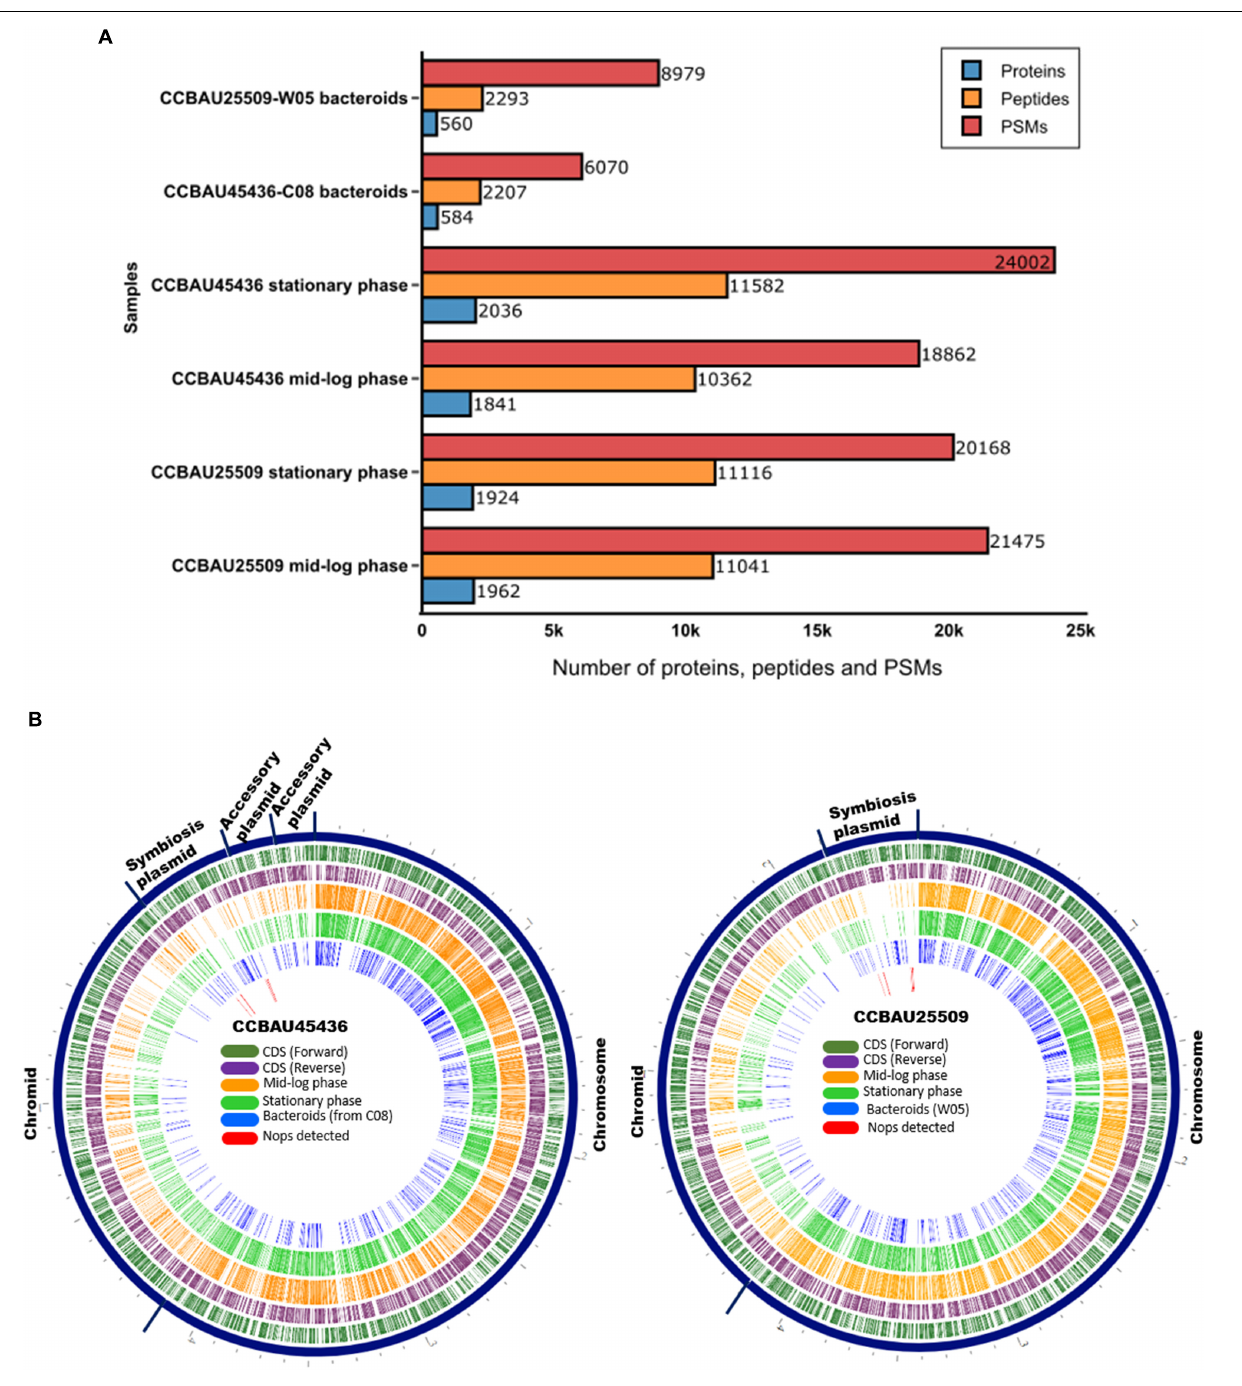
FIGURE 1 | Proteomes of Sinorhizobium fredii CCBAU25509 and CCBAU45436. (A) Number of identified proteins, peptides, and peptide spectrum matches (PSMs) from CCBAU25509 and CCBAU45436 at various growth stages in one of the three replicates. Bacteroids of CCBAU25509 and CCBAU45436 were obtained by inoculating these strains into their compatible soybean hosts, W05 and C08, respectively. (B) Circular views of detected proteins overlaid on the genomic locations of the encoding genes.